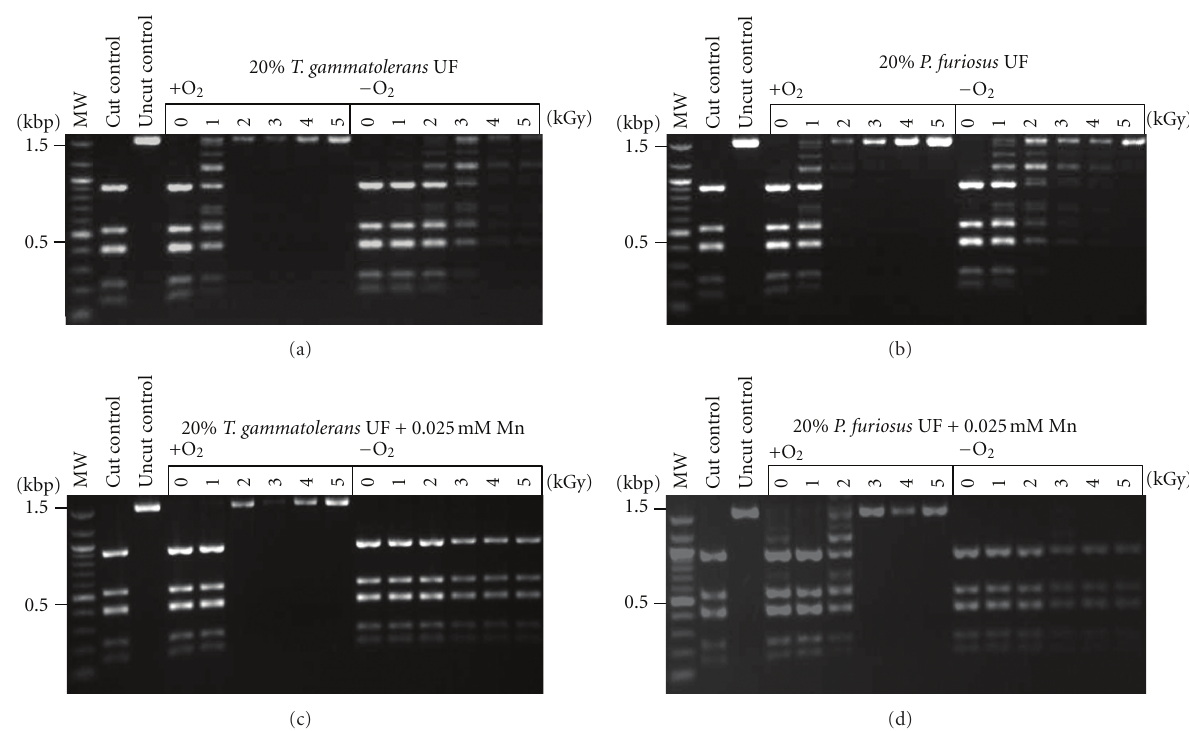
Figure 3: Protection of enzyme activity in aerobic and anaerobic conditions. The restriction enzyme Dde I was irradiated up to 5kGy in the presence or absence of oxygen in enzyme-free cell extracts (UFs) of T. gammatolerans and P. furiosus (diluted to 0.2x). Residual restriction enzyme activity was assayed by the digestion of pUC19 plasmid DNA; fragments were analyzed by agarose gel electrophoresis. The first lanes are molecular size